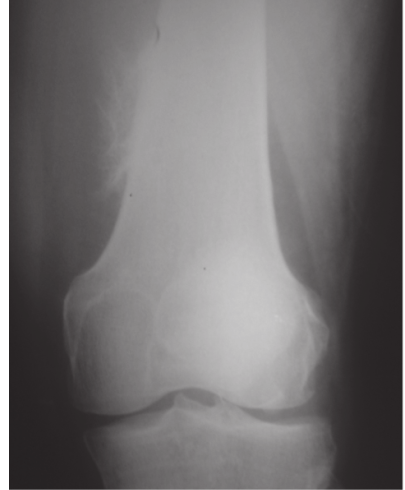
Figure 1 - Conventional X-ray: anterior view of the distal third of the left femur showing exuberant periosteal reaction in the medial cortical area associated with an increase of adjacent radiolucent soft parts (density of fatty